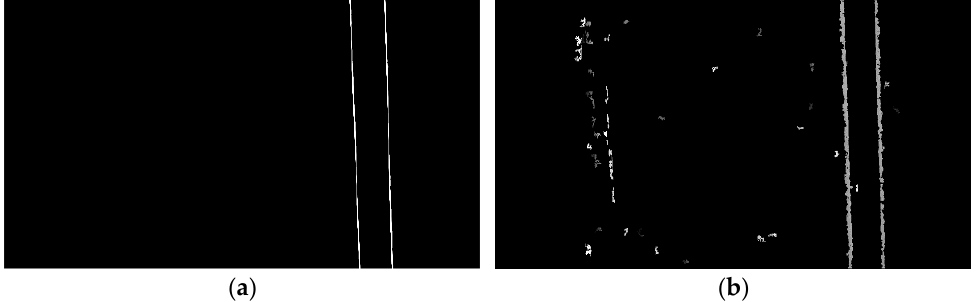
Figure 22. Lane line image after processing: ( a ) Contour image of the lane line; ( b ) Parallax image of lane lines.